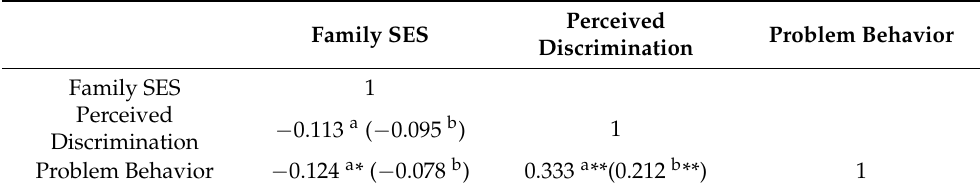
Table 3. Pearson correlation analysis of family SES, perceived discrimination, and problem behavior between left-behind children and non-left-behind children.